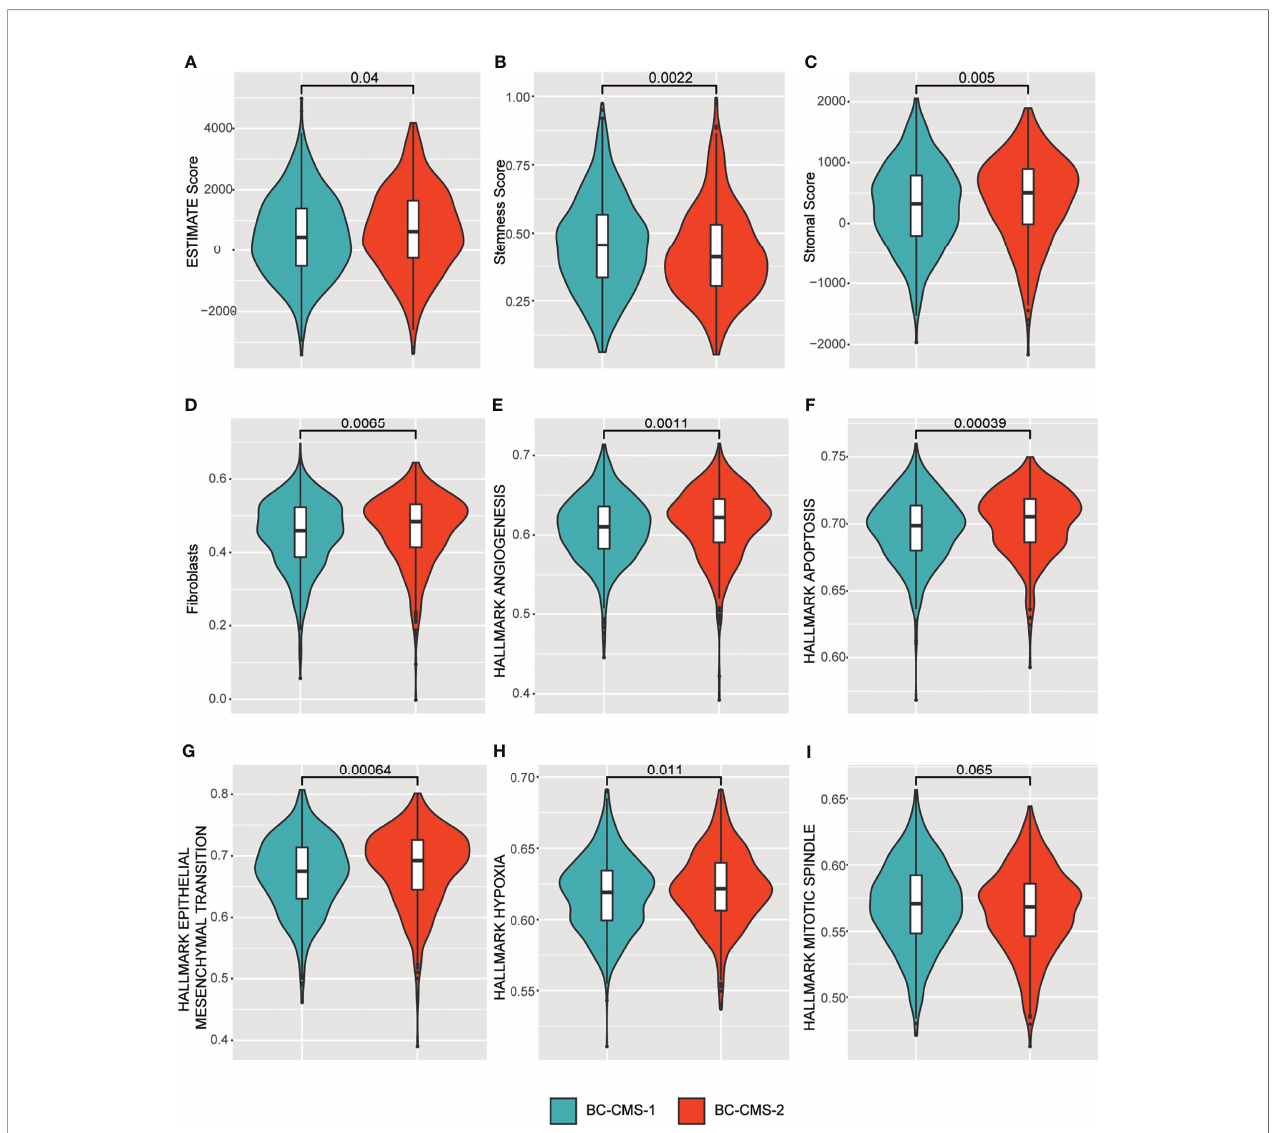
( Figure 5F ; p = 0.00039), epithelial – mesenchymal transition ( Figure 5G ; p = 0.00064), and hypoxia ( Figure 5H ; p = 0.011); and signi fi cantly decreased stemness score ( Figure 5B ; p = 0.0022); and marginally descreased mitotic spindle ( Figure 5I ; p =